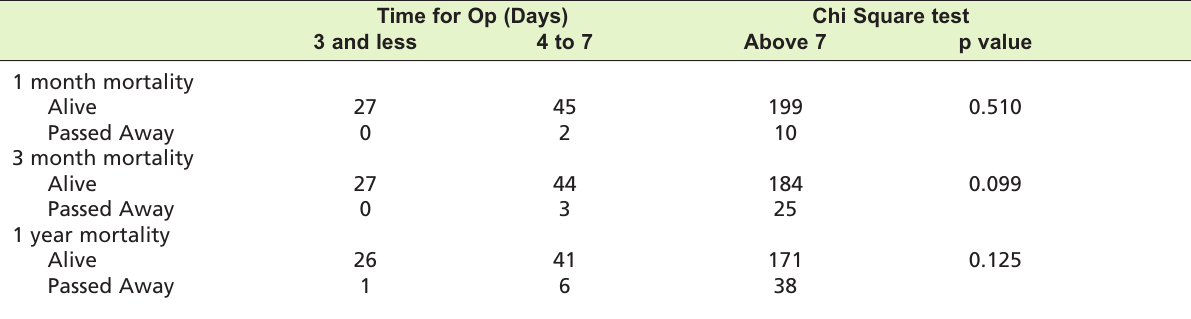
Association between mortality and time for op (days) for THR patients (n=291) Table III: Time for Op (Days)